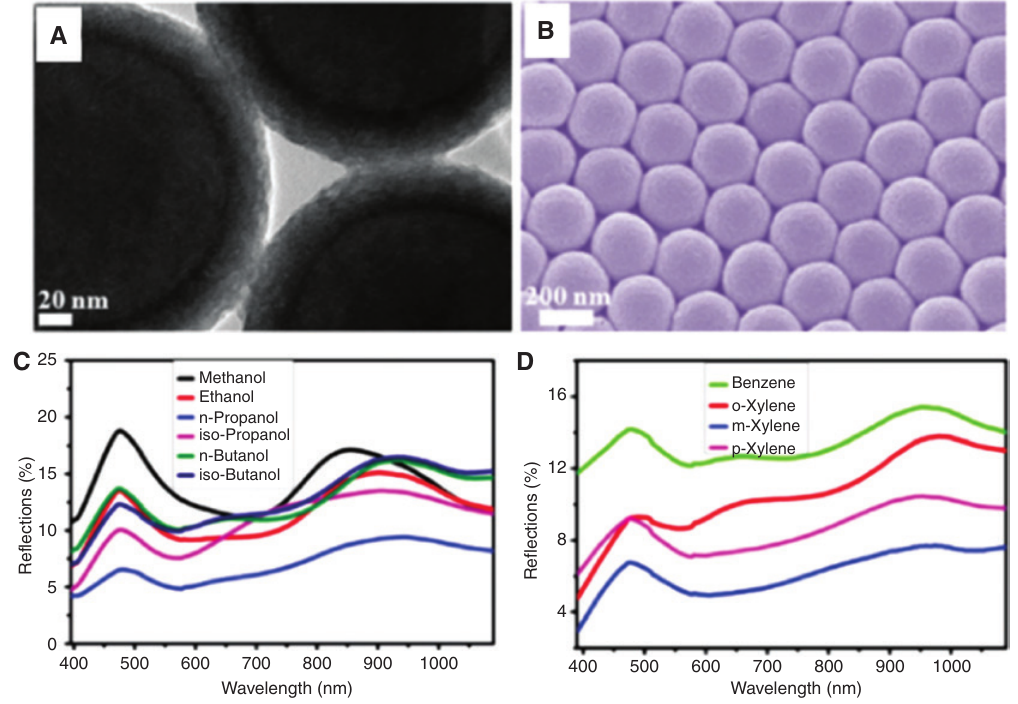
Figure 9: Self-assembled HMSS-CPCs for selective vapor sensing. (A) A TEM image of hollow mesoporous silica spheres. (B) An SEM image of HMSS-CPCs. (C and D) Reflectance spectra of HMCPCs infiltrated with alcohol and benzene series, respectively. Adapted with permission from ref. [53], COPYRIGHT 2017 The Royal Society of